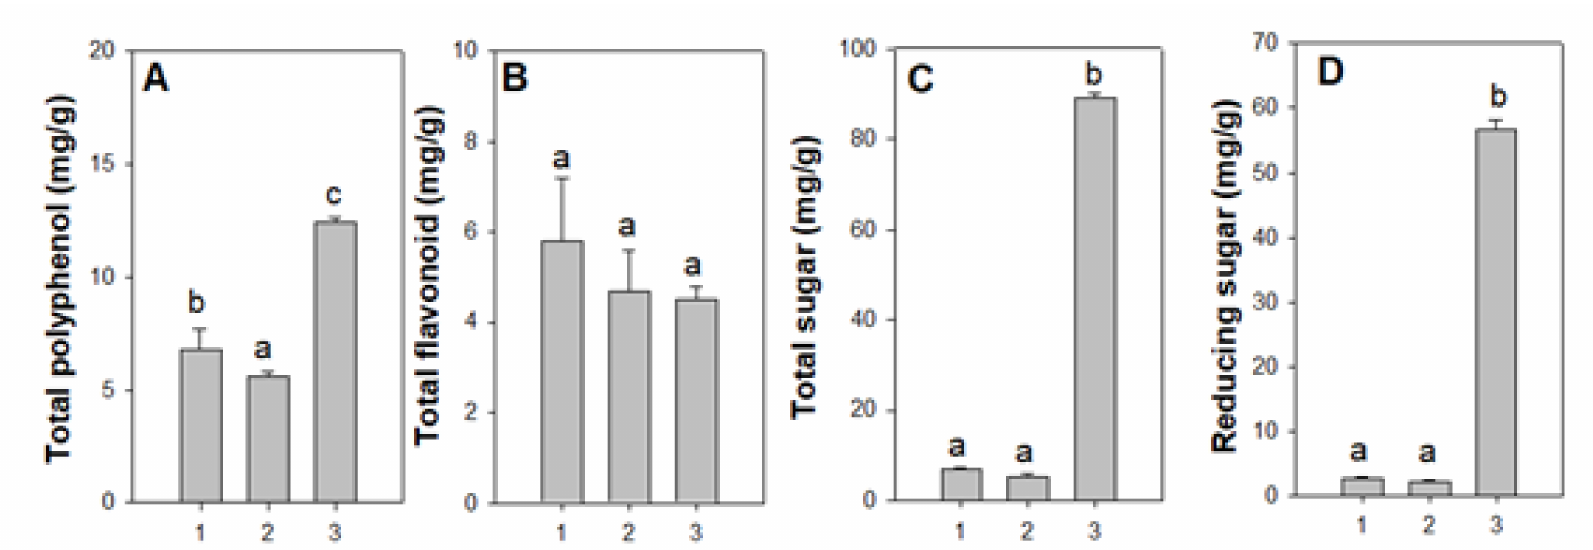
Figure 2. Functional component analyses of ethanol extracts of Buckfast honey bee drone larvae, pupae and adults from Denmark; A : Total polyphenol (mg / g), B : Total flovaonoid (mg / g), C : Total sugar (mg / g), and D : Reducing sugar (mg / g). Numbers 1, 2, 3 represent larvae, late pupae and adults, respectively. Di ff erent superscripts indicate statistically significant di ff erences ( p <